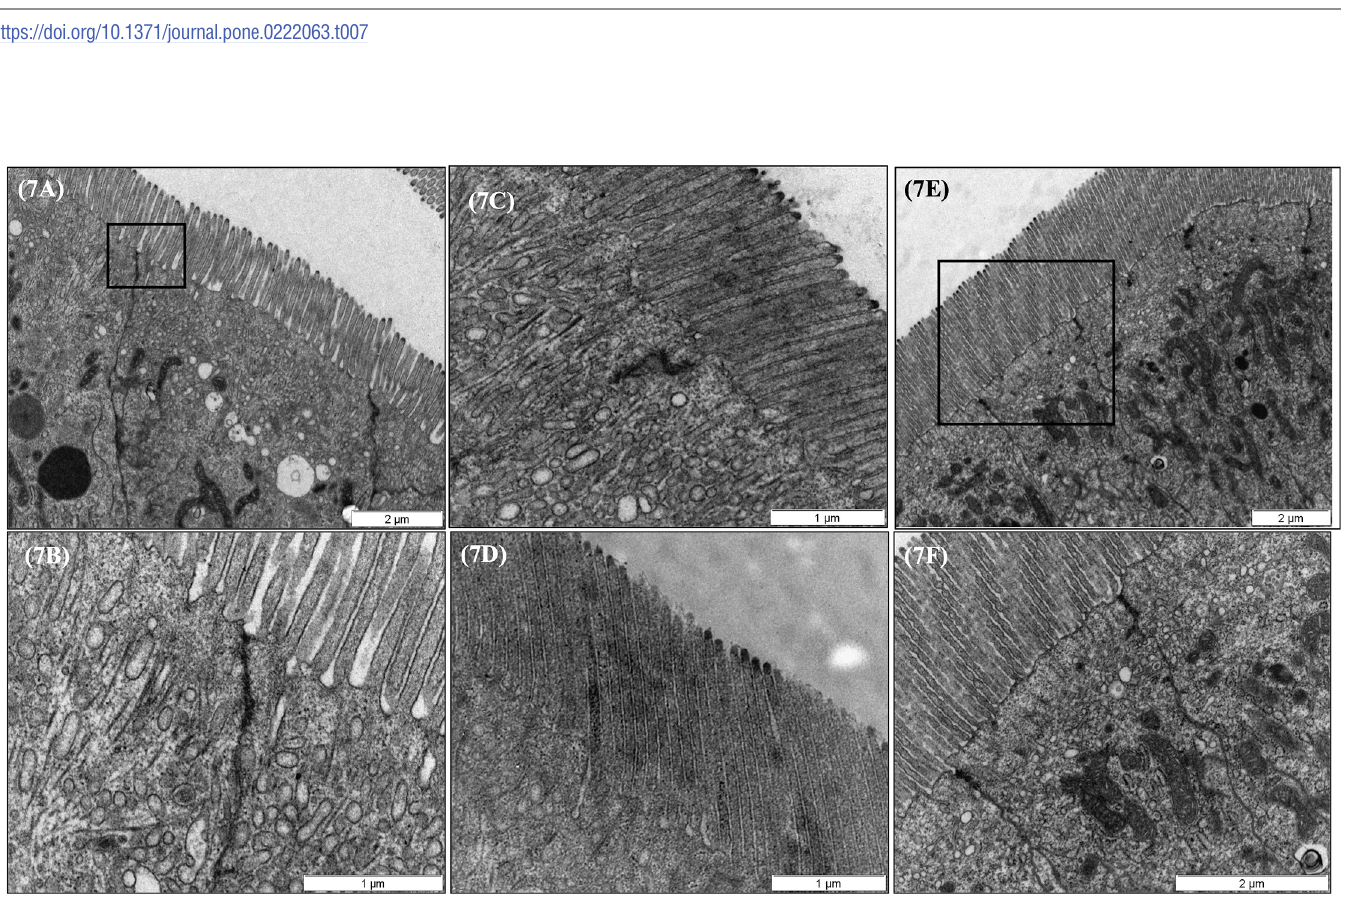
Fig 7. Representative TEM micrographs of the posterior and rectum intestinal regions of European sea bass ( Dicentrarchus labrax ) fed the different dietary treatments. (7A) Posterior gut structural pattern observed for all fish studied. Scale bar 2 μ m. (7B) Detailed micrograph of posterior gut tight junction (TJ) appearance. Observe the conserved structure. Scale bar 1 μ m. (7C) Pattern of rectum microvilli length for fish fed control and PHYTO diet and (7D) representative micrograph of rectum microvilli length for fish fed GMOS based diets which were significantly (P < 0.05) longer than fish fed the rest of the dietary treatments. Scale bars 1 μ m. No evident differences were observed in enterocyte packaging, membrane lining appearance (7E), or TJs structure (7F) among dietary treatments for rectum region. Scale bars 2 μ m. C (control diet), GMOS (5000 ppm galactomannan oliGMOSaccharides), PHYTO (200ppm phytogenic), GMOSPHYTO (5000 ppm galactomannan oligosaccharides+200ppm